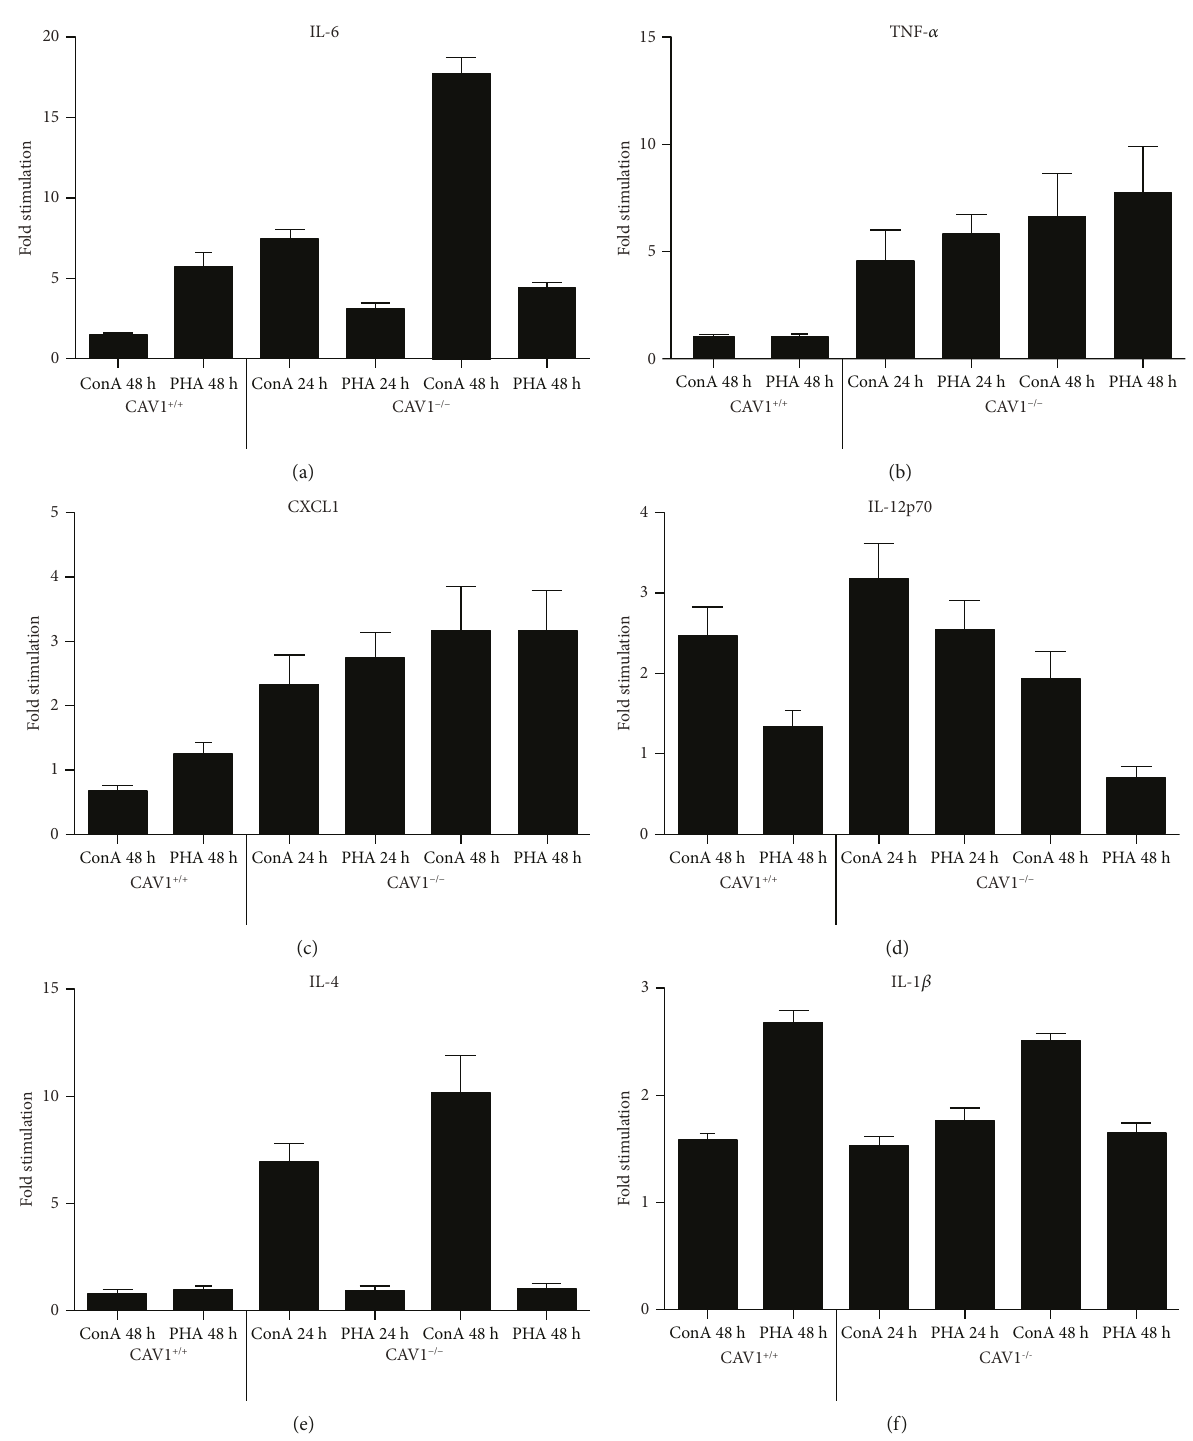
Figure 3: Cytokine production by lymphocytes upon nonspeci fi c stimulation. Cytokine levels in the cell culture media of whole blood cells, treated with nonspeci fi c lymphocyte stimuli at di ff erent time points after stimulation, as assessed by the xMAP multiplex assay: IL-6 (a), TNF- α (b), CXCL1 (c), IL-12p70 (d), IL-4 (e), and IL-1 β (f). The data represent the fold modi fi cation of the cytokines from the CAV1 − / − -derived cells versus the